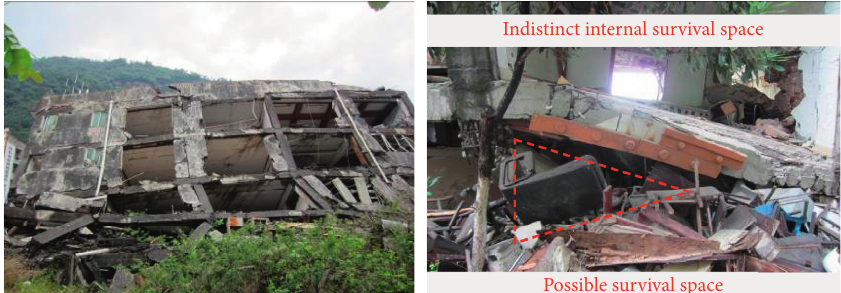
Figure 3: The final collapse state and possible survival space of EPB building (the pictures from author Dai Junwu).